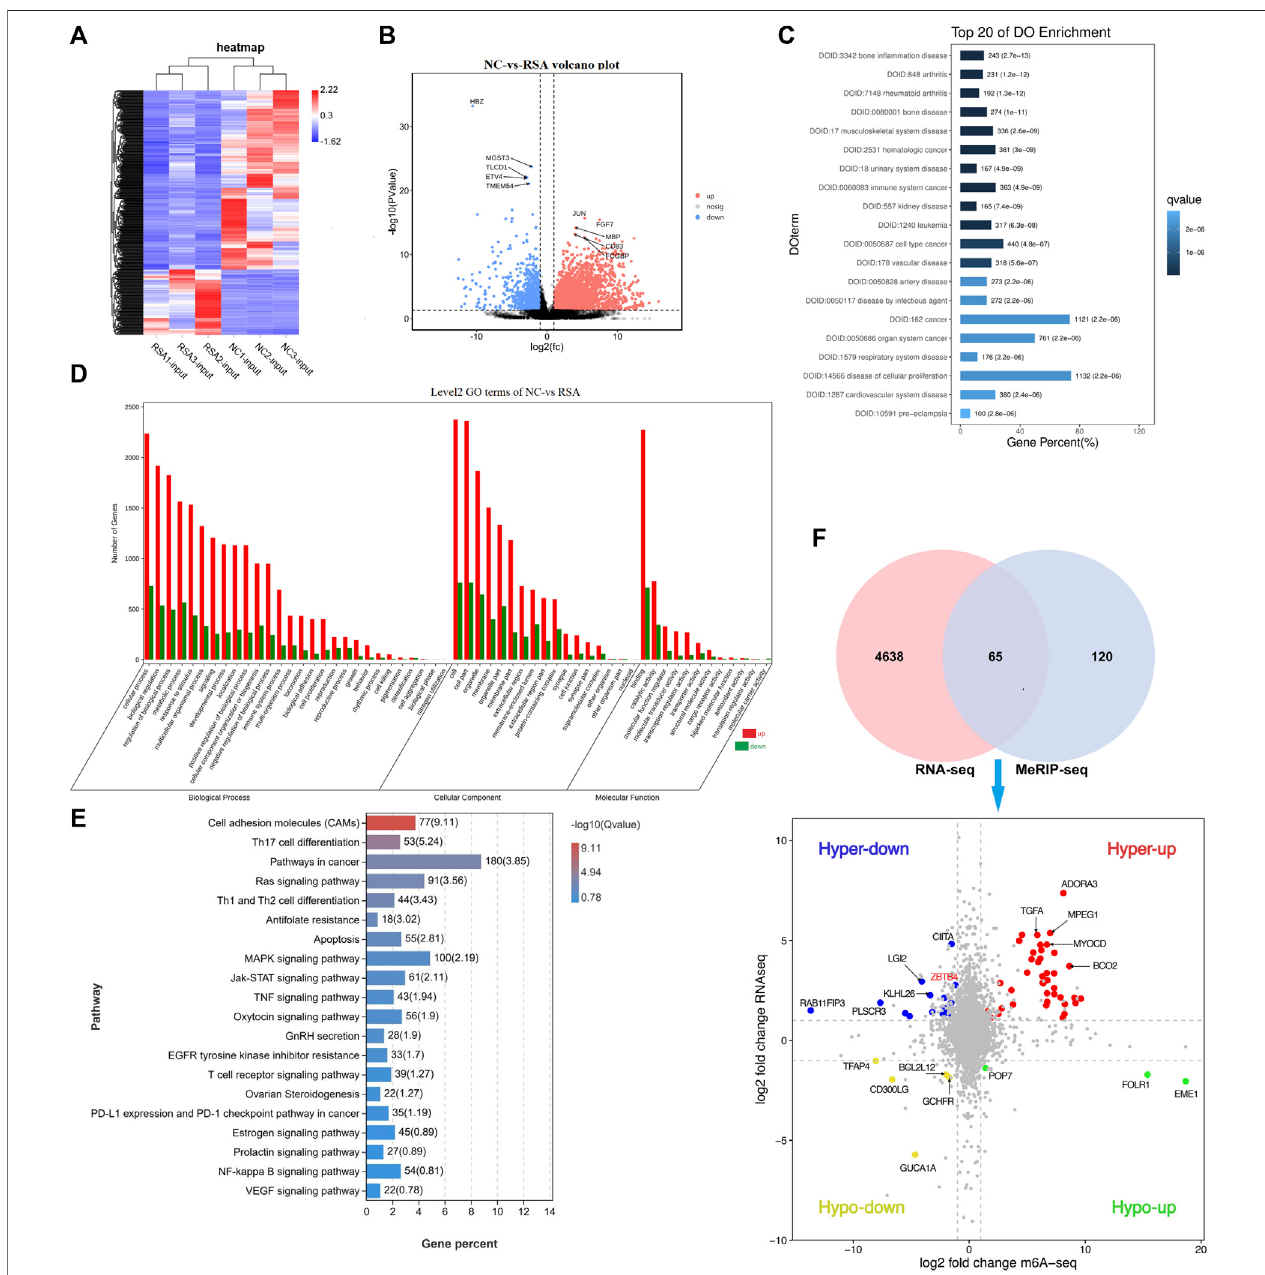
FIGURE2| OverviewofmRNApro fi leinthetwogroupsandthecorrelation withm6Amodi fi cation. (A) Heatmap conductedaccordingtotheRNA-seqdata.Inthe heatmap,eachcolumnrepresented asample,andeach rowrepresentedagene.Theexpression levelsofgenesindifferentsamplesarerepresentedbydifferentcolors. The redder the color, thehigher the expression level,and thebluer the color, the lower theexpression level. (B) Volcano plot conducted according to the RNA-seq data. The volcano plot showed the differentially expressed genes between the two groups. The farther the genes were from the center of the graph, the greater the degree of difference in the expression between the two groups. FDR < 0.05 and |log2FC| > 1 were considered with signi fi cantly different. (C) DO (Disease Ontology) histogramwasconducted accordingtothedifferentialexpression genesandshowedthetop20items.Qvalue ≤ 0.05wasconsideredwithsigni fi cantlydifferent. (D) GO histogram was conducted according to the differential expression genes. (E) KEGG pathway was conducted according to the differential expression genes showed 20 pathways that may be associated with RSA. (F) Venn diagram showed the genes with signi fi cant differences both in m 6 A modi fi cation and mRNA levels. Quadrant diagram showed the distribution of 65 signi fi cant differential